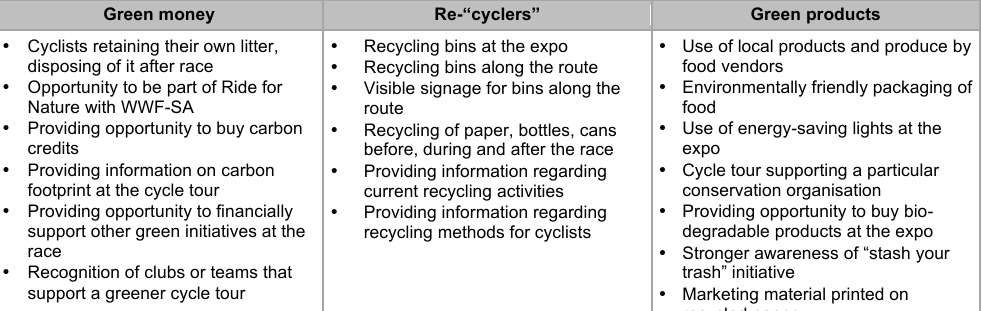
Types of cyclists by their green views Green money Re-“cyclers” Green products